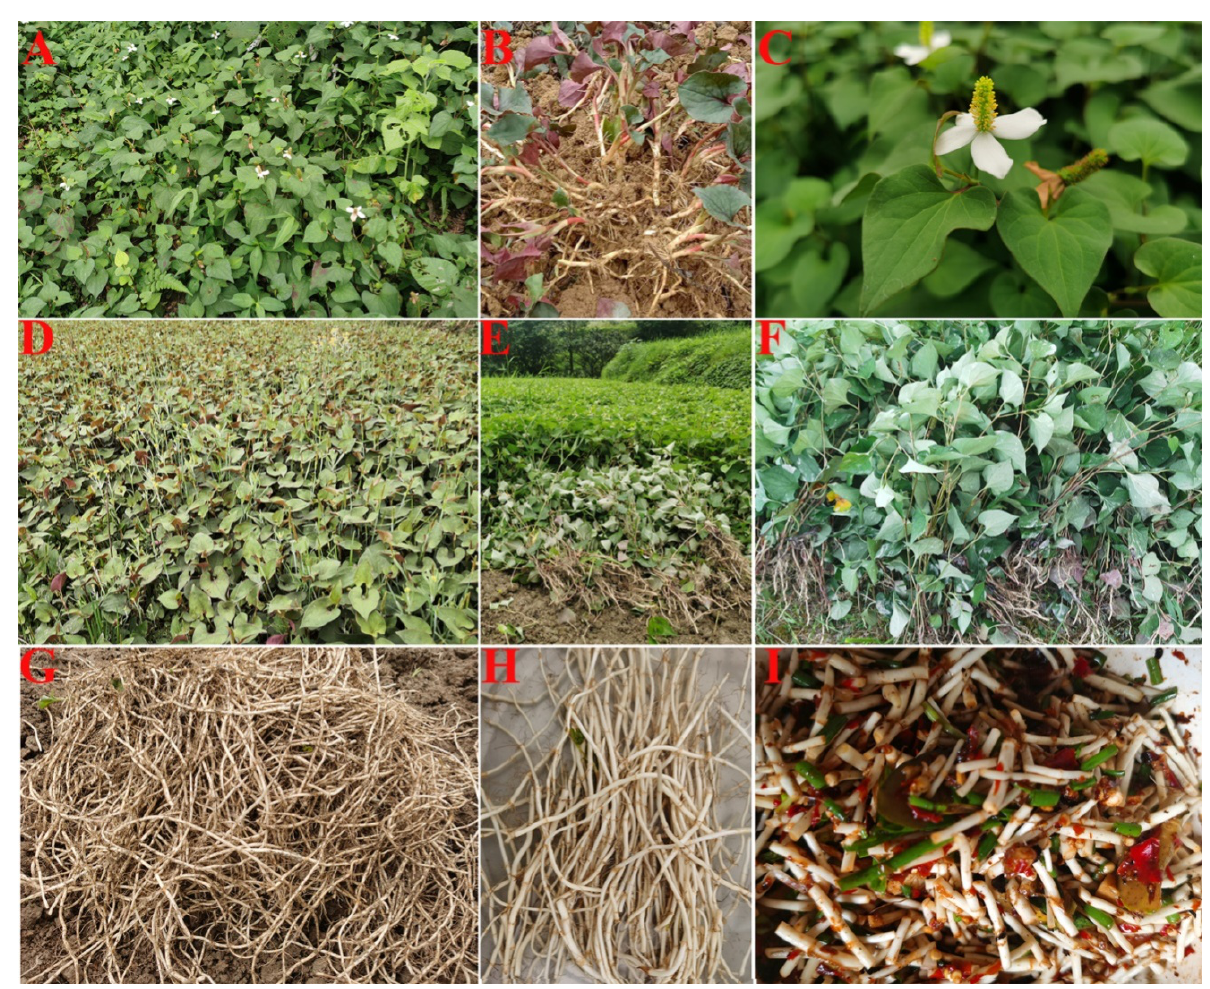
Figure 1. Morphological characteristics and utilization of H. cordata. ( A ). Wild H. cordata ; ( B ). Above ground and underground part of H. cordata ; ( C ). Flower and leaves of H. cordata ; ( D ). Cultivated H. cordata ; ( E ). Harvested H. cordata ; ( F ). H. cordata above ground part used for medicinal material; ( G , H ). H. cordata roots as vegetable; ( I ). Fresh roots used for salad.